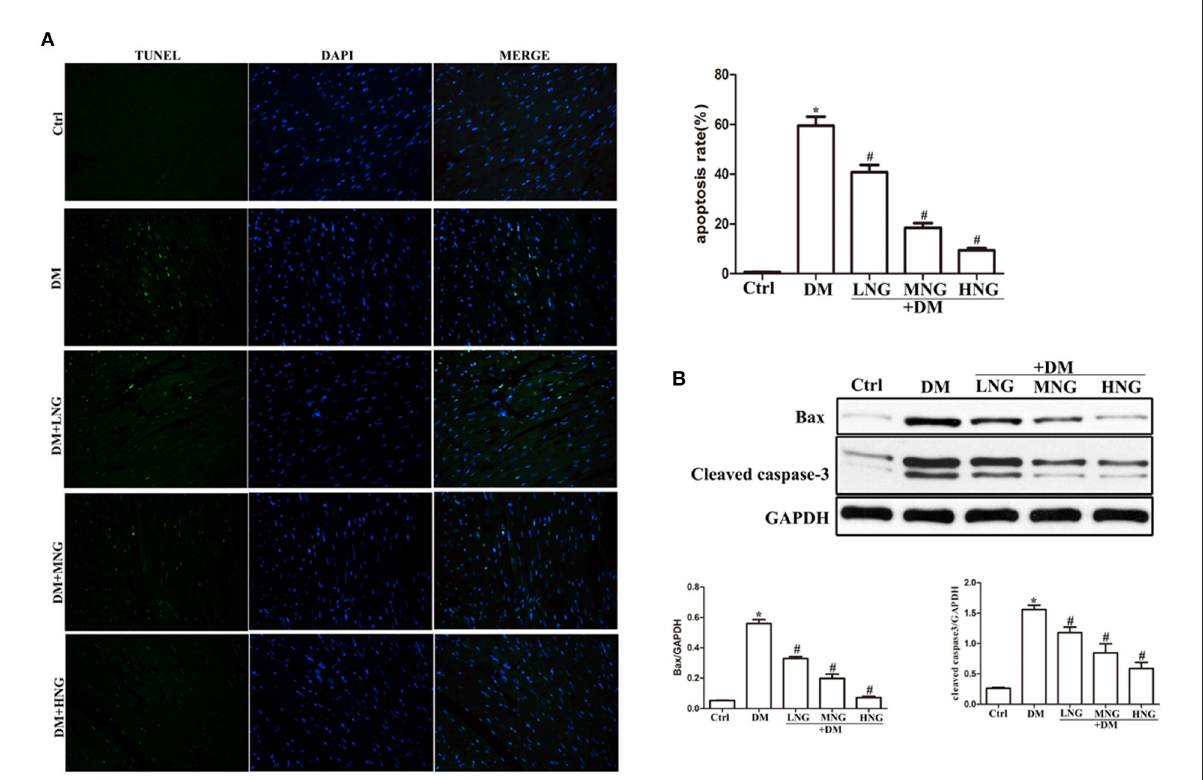
FIGURE2 NG reduces apoptosis of cardiomyocytes in cardiac tissues of diabetic mice. (A) Representative images of TUNEL staining for each group, fluorescence microscope (200 × ). Data are presented as the mean ± SD ( n = 3). * P < 0.05 vs. Ctrl group; # P < 0.05 vs. DM group. (B) Quantitative analysis of the protein expression of Bax and cleaved caspase-3 in cardiac tissues. Data are expressed as mean ± SD ( n = 3), * P < 0.05 vs. Ctrl group; # P < 0.05 vs. DM group.